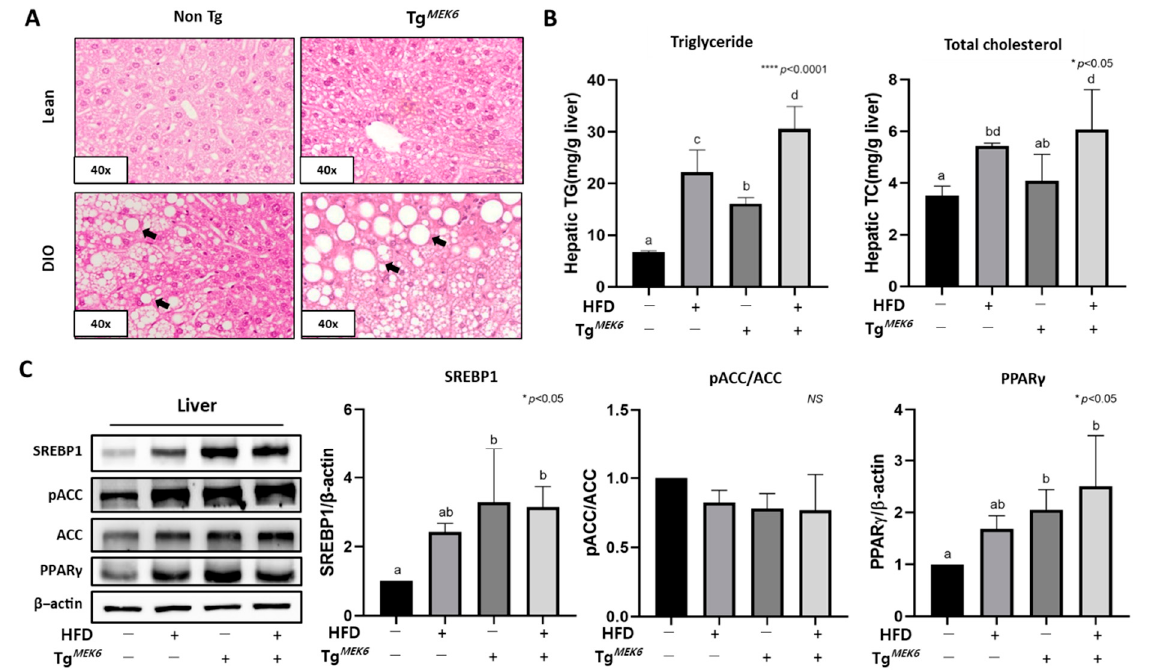
Figure 5. MEK6 overexpression promotes lipid accumulation in liver. ( A ) Representative sections of H&E staining show lipid accumulation and lipid droplet (black arrows) in liver; 40x magnification ( B ) Triglyceride (TG) and total cholesterol (TC) levels was measured in the lipid ‐ extracts of liver. ( C ) The expression of proteins (SREBP1, pACC/ACC and PPAR γ ) related to lipid accumulation were confirmed in the liver by western blotting. Results are expressed as mean ± SD. Data were assessed by one ‐ way ANOVA with Duncan’s test (NS, not significant by unpaired t ‐ test. *; p < 0.05, ****; p < 0.0001). Superscript letters (a–d) indicate the significant differences between the groups at p < 0.05. +, treatment or transfection; − , non ‐ treatment or non ‐ transfection.